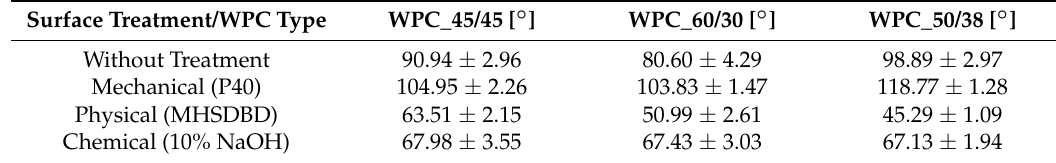
Table 1. Average contact angle α of WPC surfaces WITHOUT and WITH surface treatment 1 .